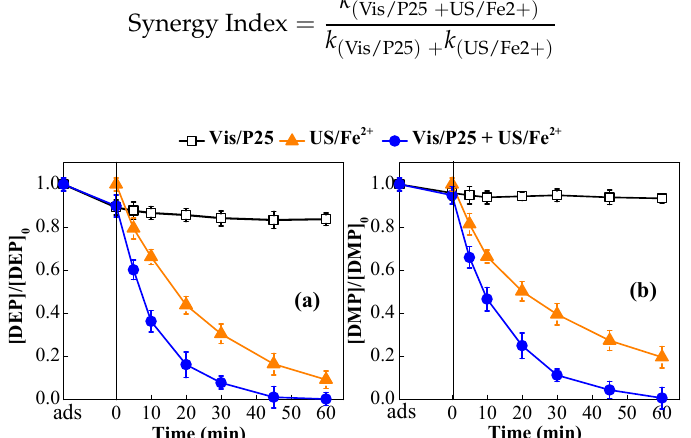
Figure 1. The degradation kinetics of diethyl phthalate (DEP) ( a ) and dimethyl phthalate (DMP) ( b ) in the processes of P25 photocatalysis (Vis/P25), sono-Fenton (US/Fe 2+ ), and the coupling (Vis/P25 + US/Fe 2+ ) (conditions: [DMP] 0 = 0.01 mM, [DEP] 0 = 0.01 mM, P25 dosage 0.5 g L −1 , adsorption time 20 min, [Fe 2+ ] 0 = 0.02 mM).